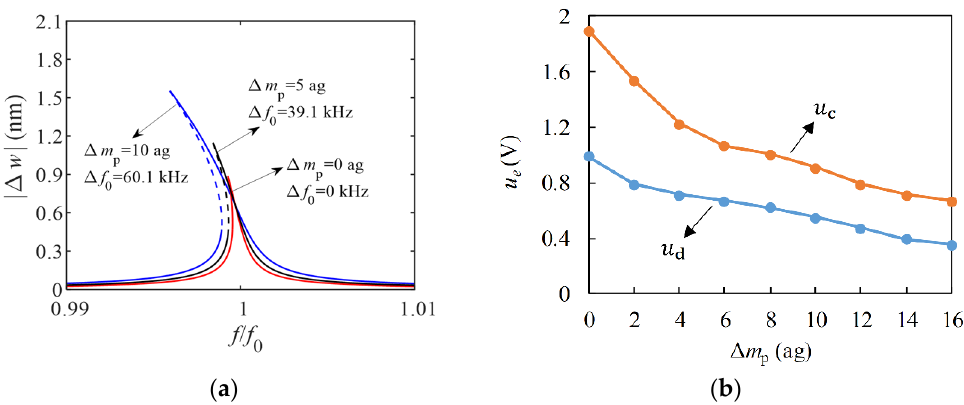
Figure 5. Effect of ∆ m p on resonance characteristics: ( a ) Effect of ∆ m p on the amplitude-frequency characteristic curve; ( b ) effect of ∆ m p on critical drive